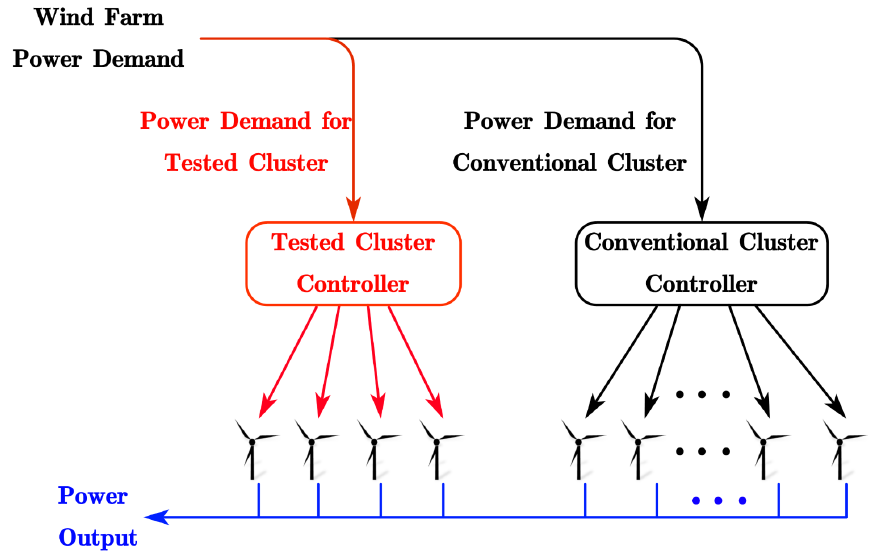
Figure 13. Wind farm control